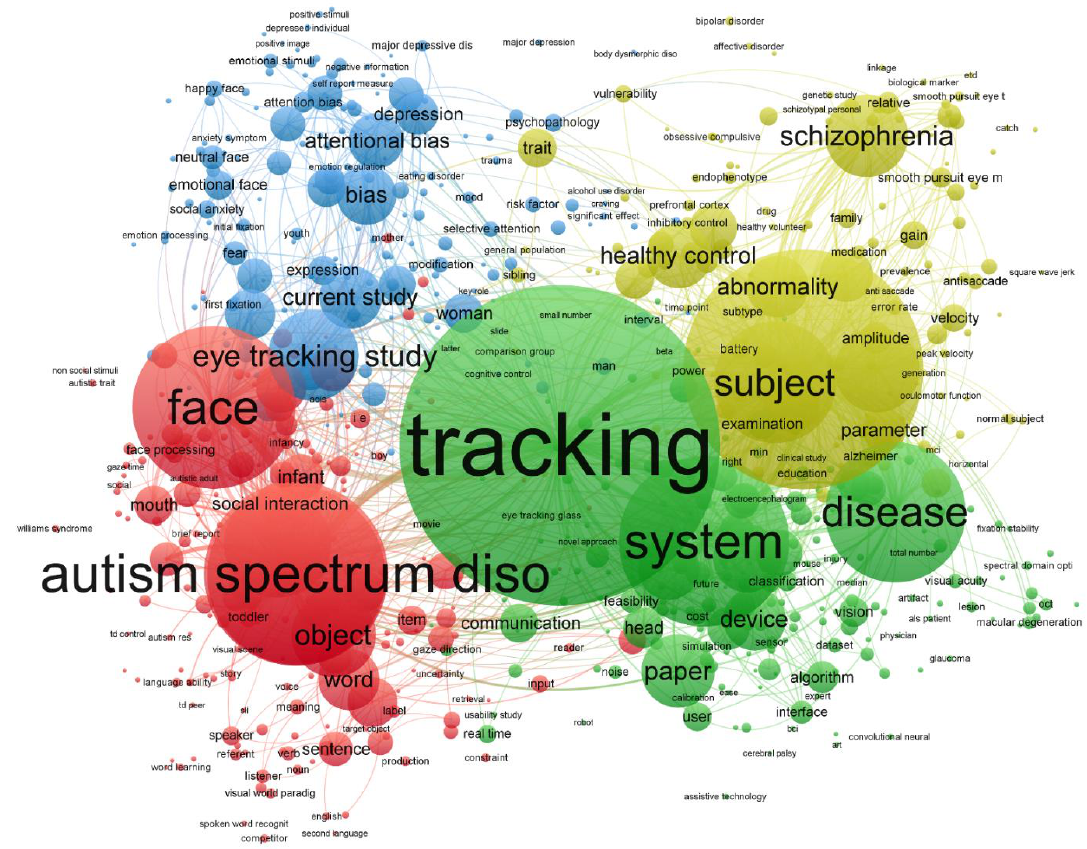
Figure 1. Co-occurrence term map of studies investigating eye tracking in different disorders. A word cloud plotted using the most frequent keywords (after the exclusion of words included in the search strategy), is shown in Figure 2. As in the co-occurrence term map, autism spectrum disorders were the most represented of the conditions, followed by schizophrenia, depression, anxiety, Parkinson’s disease and Alzheimer’s disease.